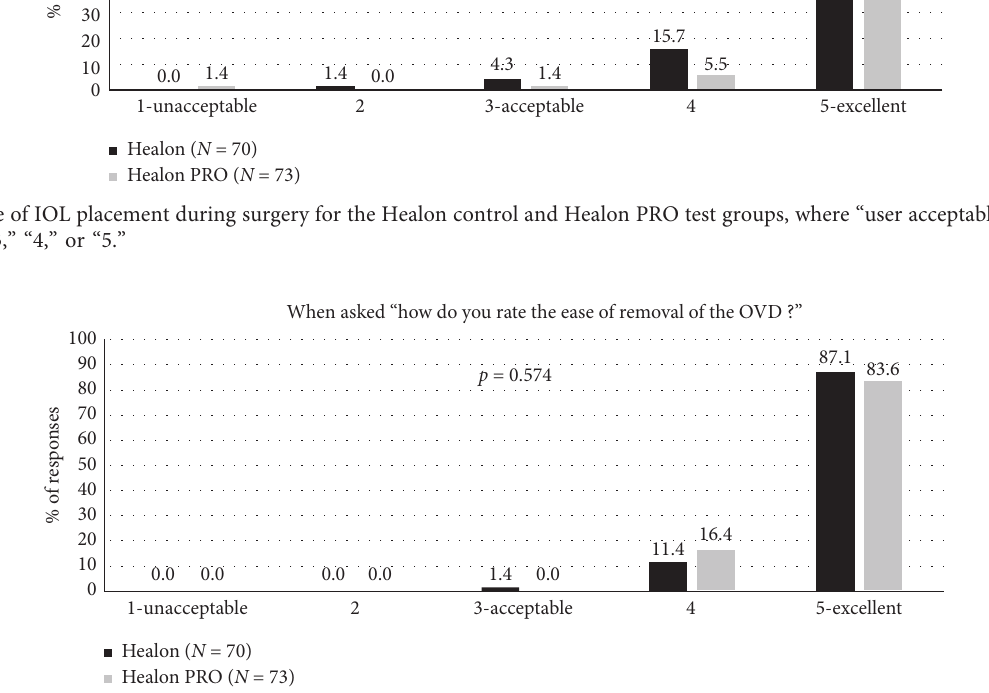
Figure 8: Ease of removal of the OVD during surgery for the Healon control and Healon PRO test groups, where “user acceptable” indicated a response of “3,” “4,” or